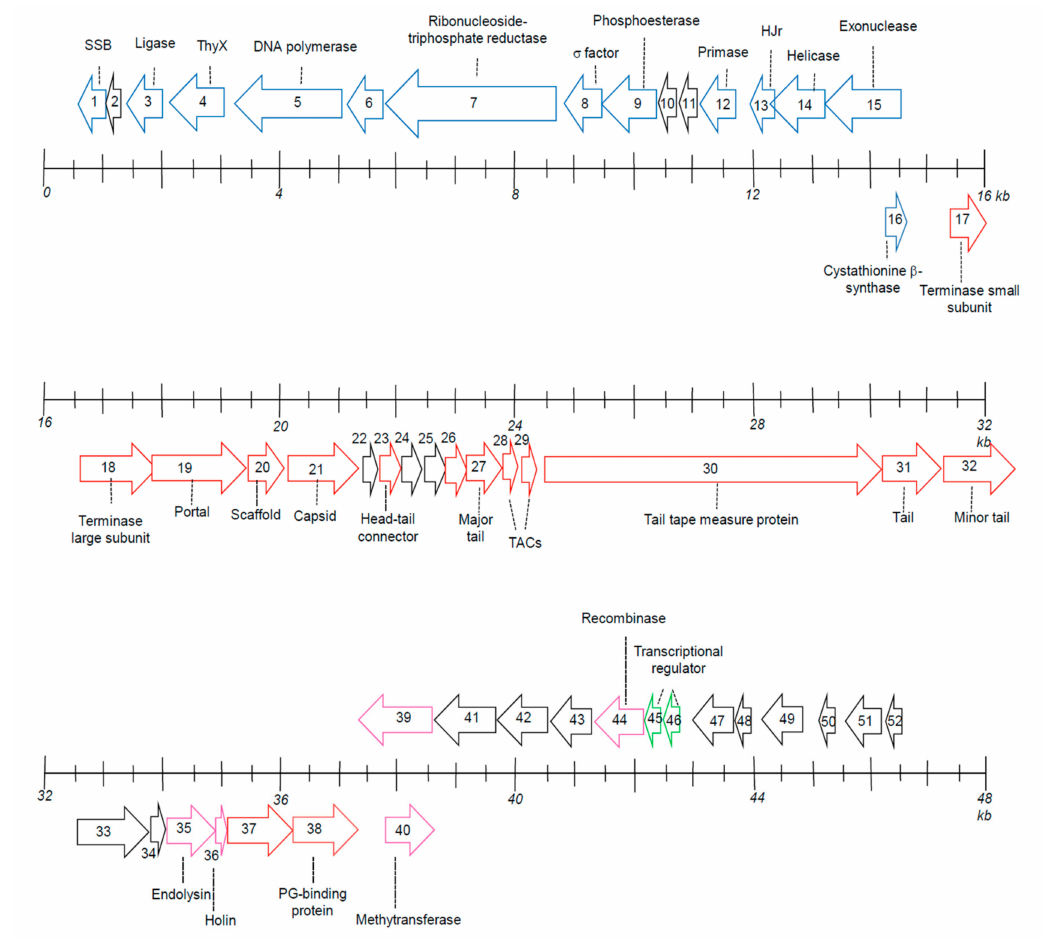
Figure 5. Organization of ORFs in the P318 genome. The scales represent the length of the genome and the nucleotide positions in kb are given. Arrowed boxes denote the predicted ORFs in the genome. ORFs pointing to the right are on the forward strand, while those pointing to the left are on the complementary strand. ORFs colored blue, red, green, and magenta represent proteins involved in phage DNA replication, virion morphogenesis, transcription control, cell wall lysis, DNA modification, and DNA recombination. The abbreviations are as follow: SSB, ssDNA binding protein; ThyX, FAD-dependent thymidylate synthase; HJr, Holliday junction resolvases; TACs, tail assembly chaperone; PG, peptidoglycanwhich may protect phage DNA from host restriction endonuclease